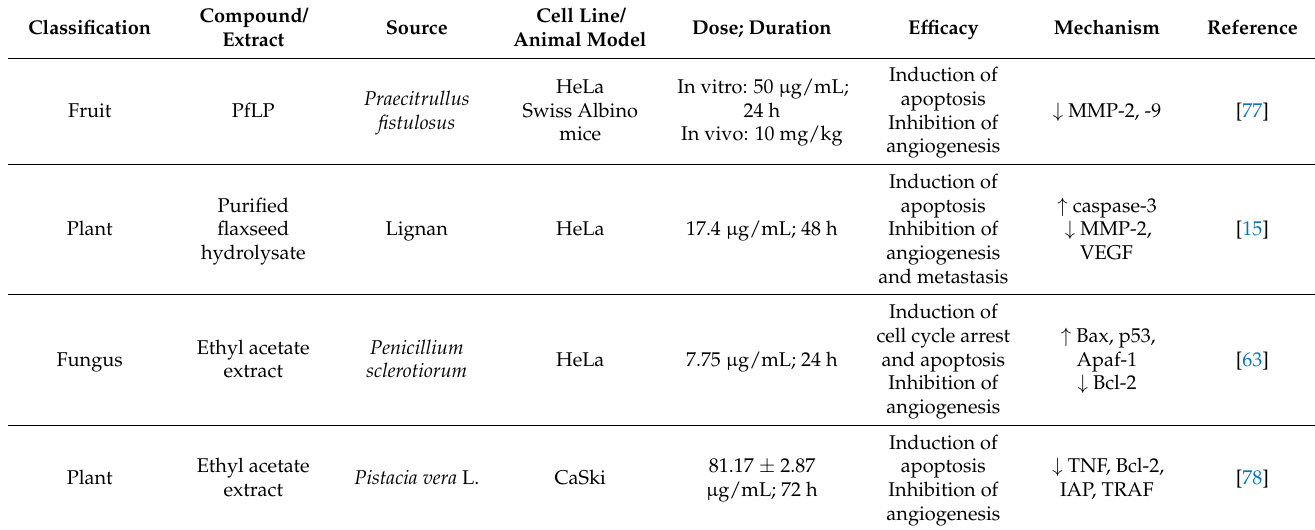
Table 3. Angiogenesis inhibiting natural